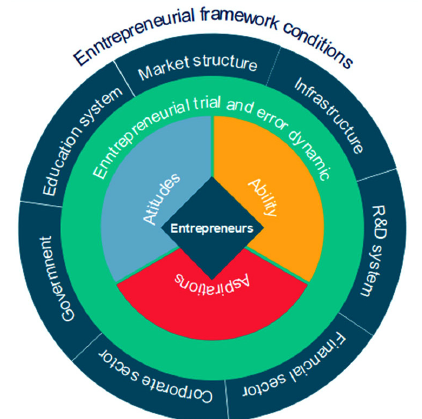
Figure 2. The Entrepreneurial ecosystem configuration (source: Global Entrepreneurship Development Institute, 2019, created by the